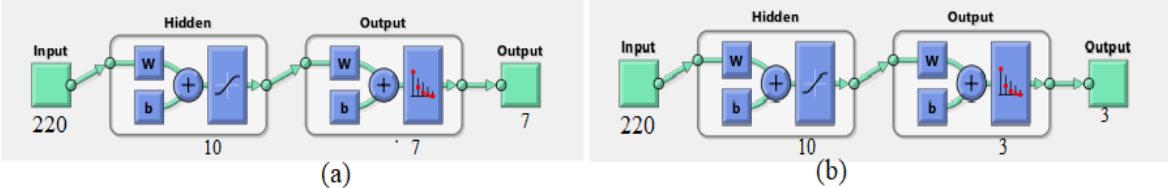
Figure 11. The training of the process of the ANN algorithm, considering the different datasets used. ( a ) The ISIC 2018 dataset. ( b ) The PH2 dataset.